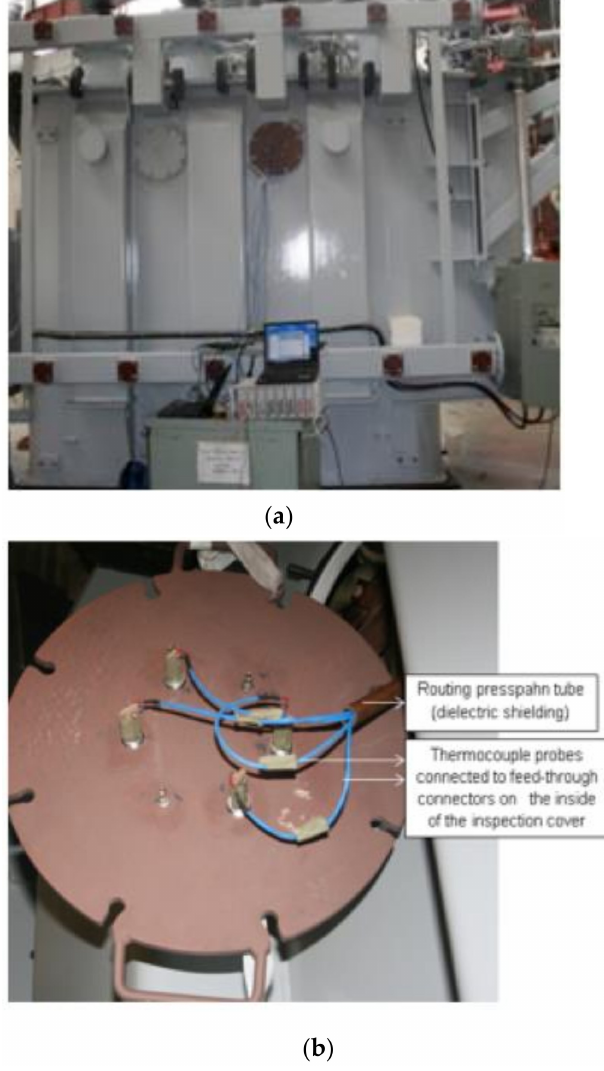
Figure 7. ( a ) Measurement setup. ( b ) Connected thermocouple